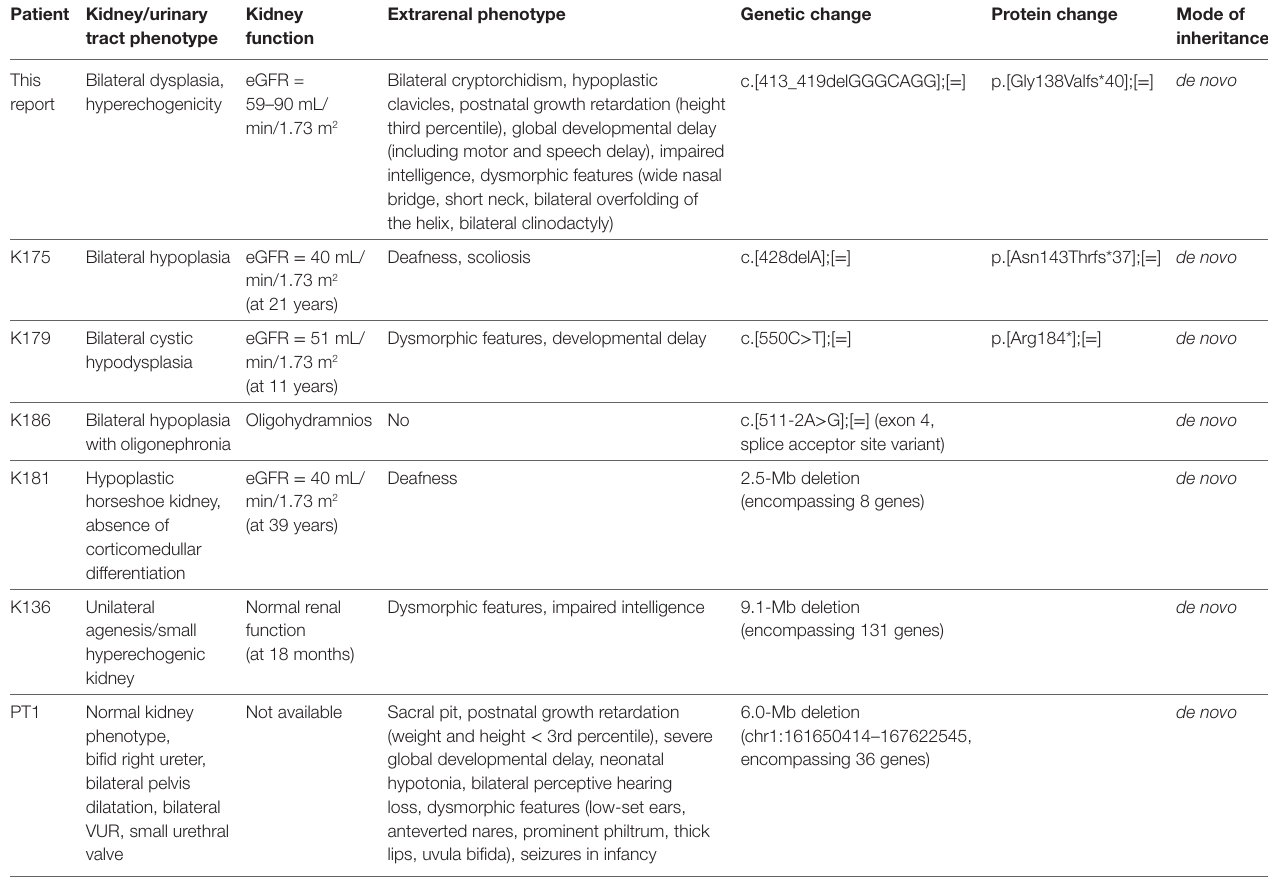
taBLe 1 | Summary of genetic changes in PBX1 and clinical features reported so